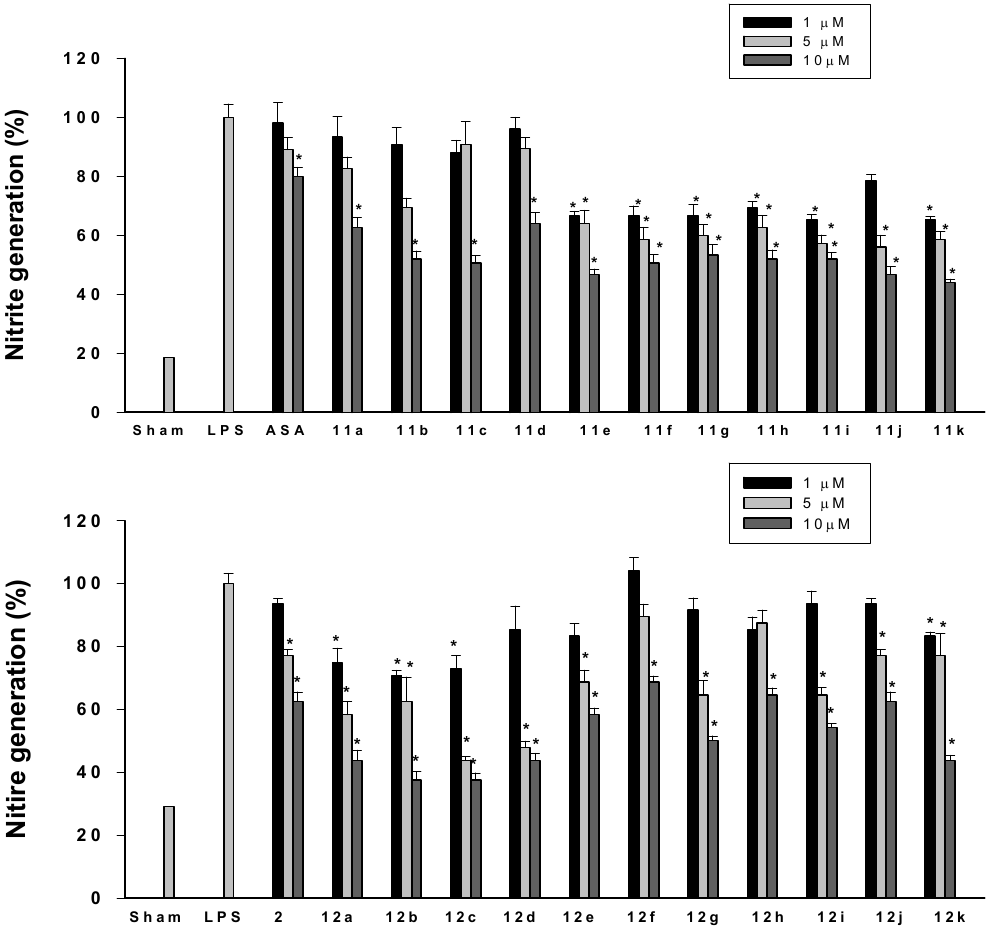
Figure 2. Effect of modafinil derivatives 11a – k , 12a – k and aspirin (ASA) on nitrite production in LPS-stimulated BV-2 microglia cells. Cells were treated with 100 ng/mL LPS, and then various concentrations of test compounds (1 µM, 5 µM, and 10 µM) were added for 24 h at 37 °C. Values indicate nitrite production from culture supernatants of LPS-treated cells with or without compounds. Data represent the mean ± standard deviation of three observations. * p < 0.05 in comparison with LPS treated